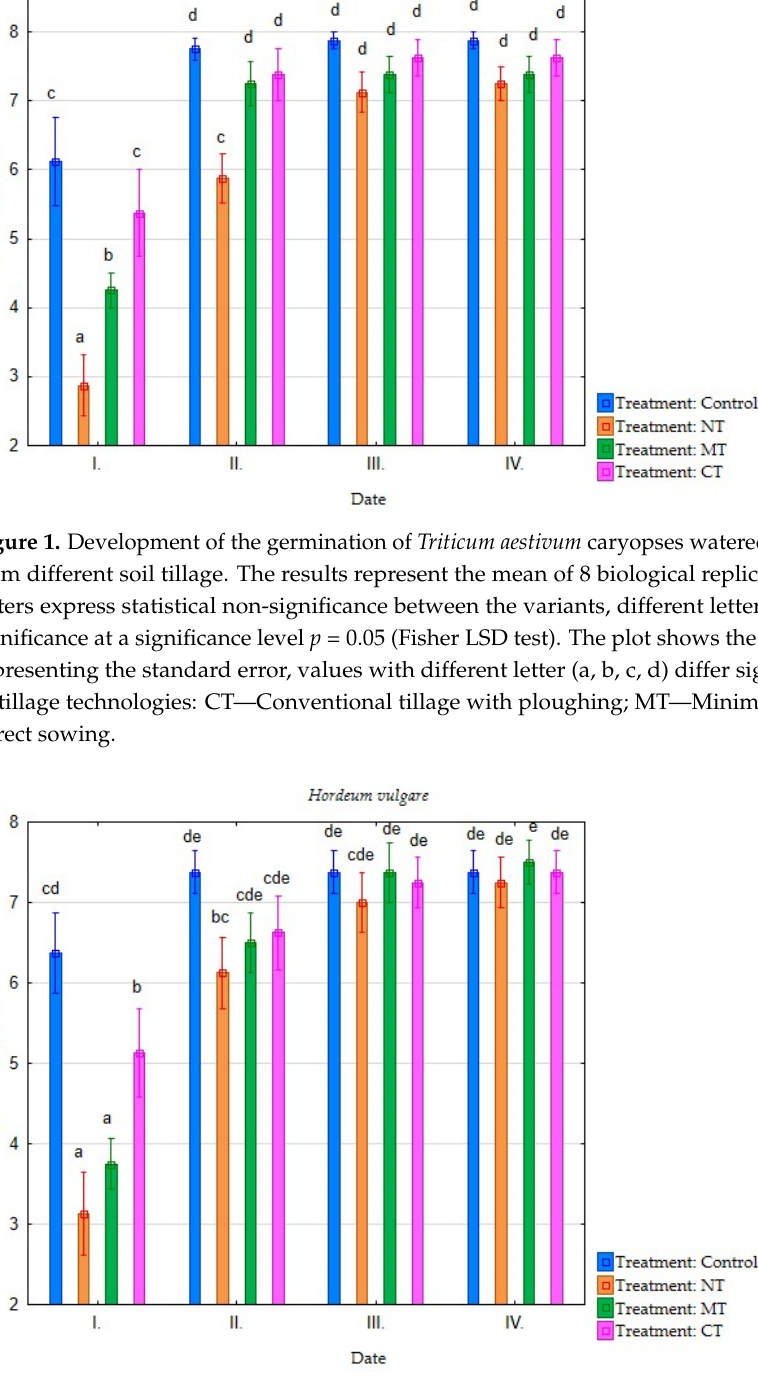
Figure 2. Development of the germination of Hordeum vulgare caryopses watered with soil leachates from different soil tillage. The results represent the mean of 8 biological replicates ± SE. Identical letters express statistical non-significance between the variants, different letters express statistical significance at a significance level p = 0.05 (Fisher LSD test). The plot shows the mean, the whiskers representing the standard error, values with different letter (a, b, c, d, e) differ significantly. Variants of tillage technologies: CT—Conventional tillage with ploughing; MT—Minimum tillagethe; NT— Direct sowing.